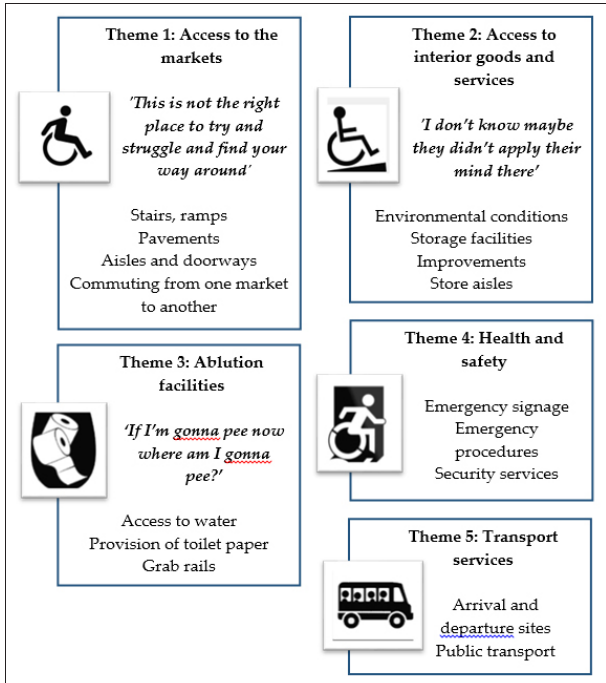
FIGURE 2: Themes emerging from the study.